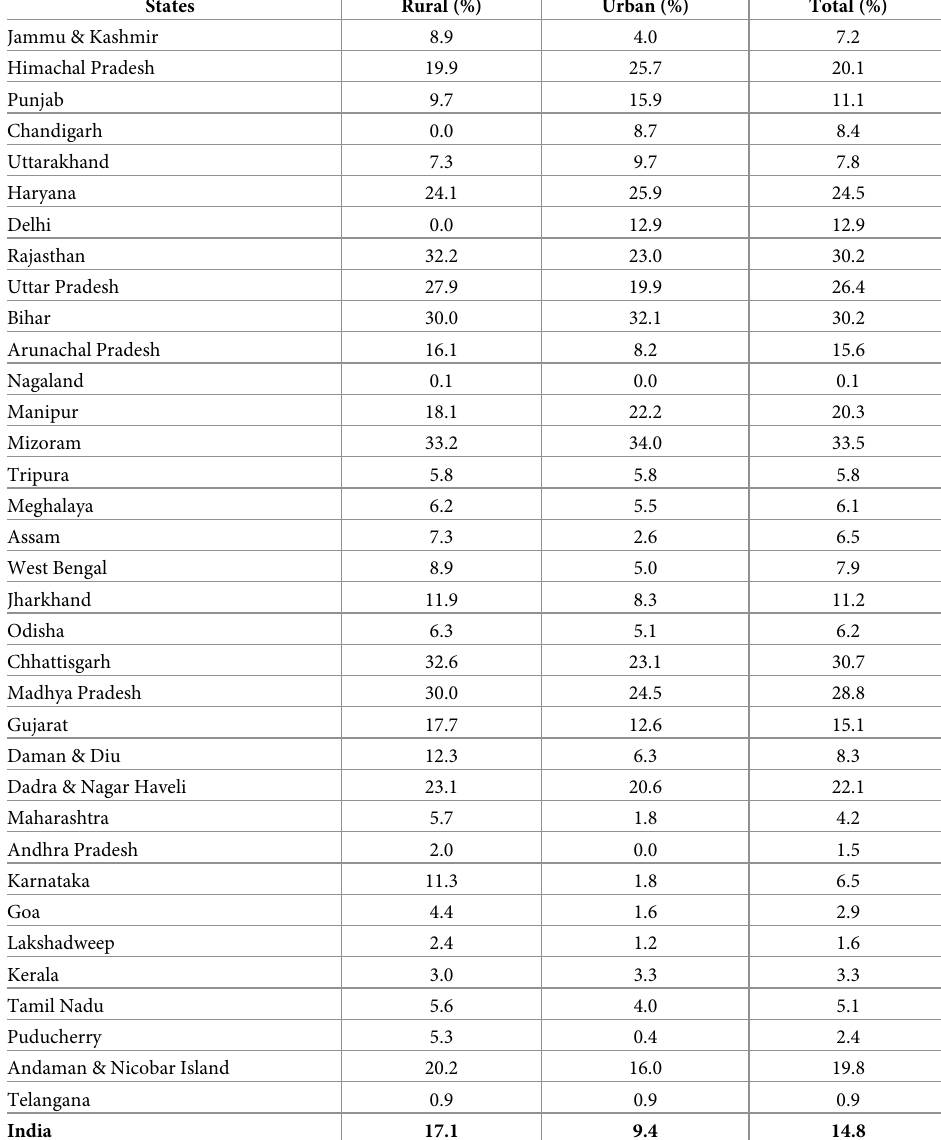
Table 2. Percentage of older adults suffered from diarrhoea in states of India, 2017–18.